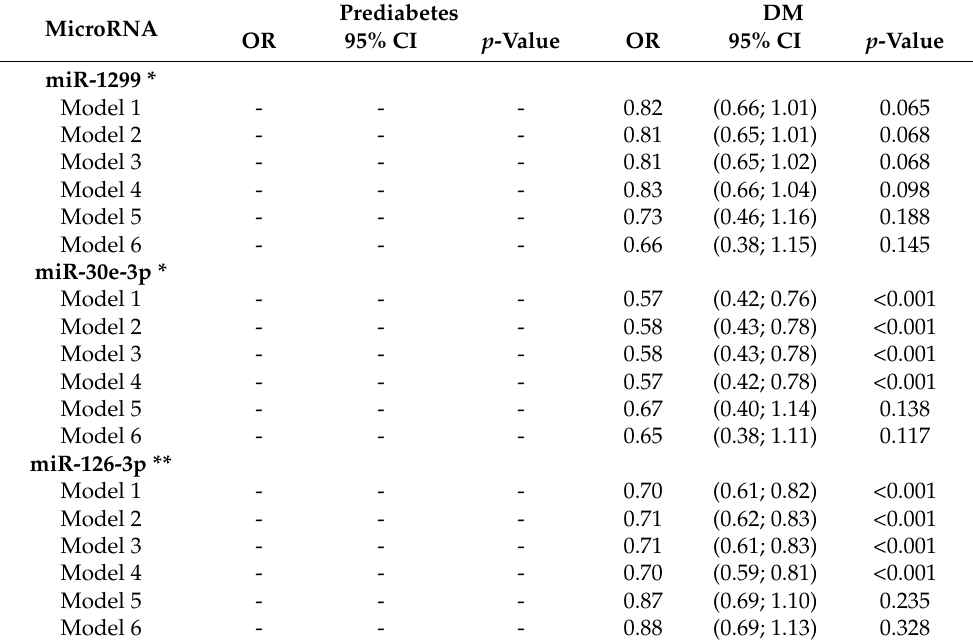
Table 5. Multivariate regression analysis of miRNAs for diabetes using prediabetes as